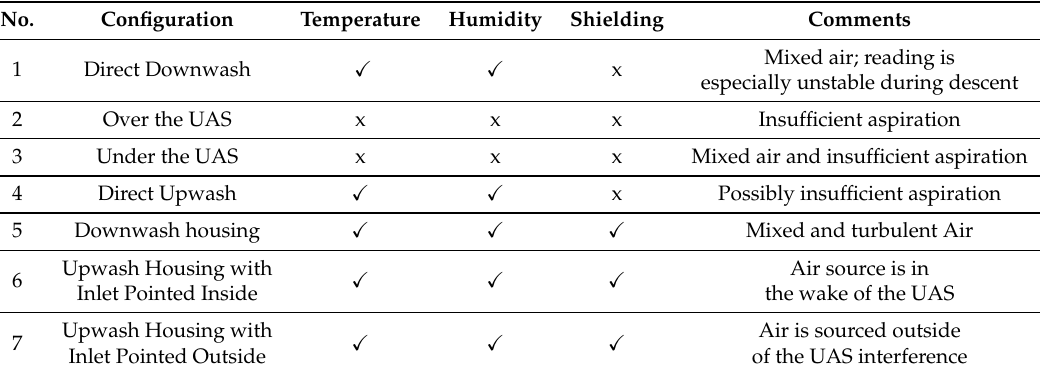
Table 1. A comparison of the different sensor configurations: (cid:88) the availability of aspiration for temperature–humidity (TH) and atmospheric